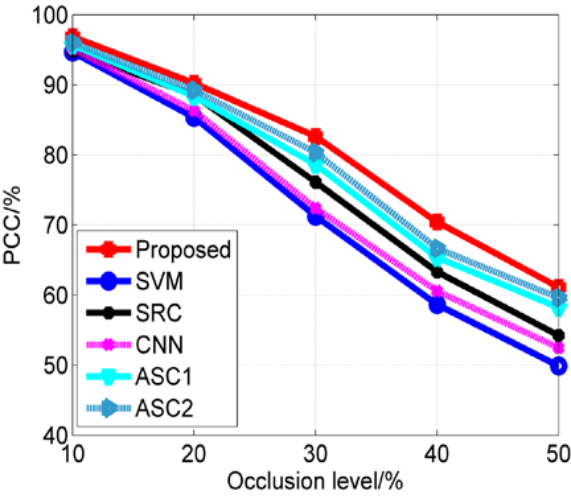
Figure 13. Performance of different methods under partial occlusion.